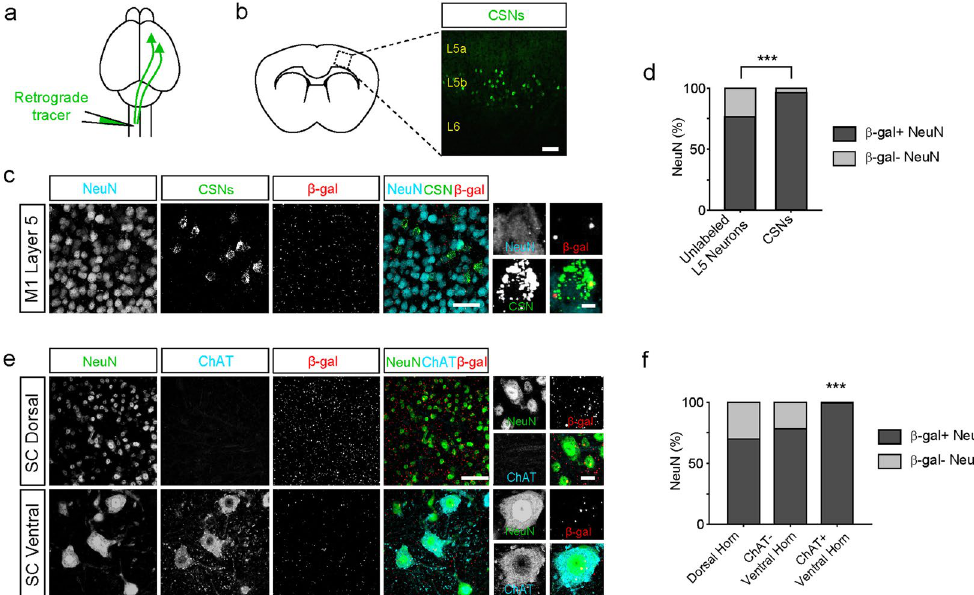
Figure 3. C9orf72 promoter activity is enriched in corticospinal and spinal motor neurons. ( a ) Schematic of the experimental design. Green fluorescent retrograde tracers were injected into the contralateral cervical spinal cord to retrogradely label corticospinal neurons in C9orf72 LacZ/ + mice. ( b ) Retrogradely labelled corticospinal neurons are shown in layer 5 (L5) of primary motor cortex. Scale bar: 100 μ m. ( c ) Representative images of L5 of motor cortex showing NeuN-positive neurons (cyan), retrogradely labelled corticospinal neurons (green) and β -gal staining (red). High magnification images show β -gal puncta within a corticospinal neuron ( rightmost panels ). Scale bars: 50 μ m and 5 μ m. ( d ) The percentage of unlabeled NeuN-positive neurons and of corticospinal neurons (CSNs) containing β -gal puncta in L5 of motor cortex (Unlabeled NeuN-positive neurons: 1357 of 1771 cells, 76.6%; CSNs: 132 of 137 cells, 96.4%; n = 5 mice for each group, p < 0.0001, Chi- Square test). Unlabeled NeuN-positive neurons and retrogradely labelled corticospinal neurons were analyzed from the same images. ( e ) Representative images of the dorsal ( top ) and ventral horn ( bottom ) of the spinal cord immunostained for NeuN (green), Choline acetyltransferase (ChAT; cyan), and β -gal (red). High magnification images show β -gal puncta within NeuN-positive neurons in the dorsal horn ( top right) and a ChAT-positive neuron in the ventral horn ( bottom right ). Scale bars: 50 μ m and 10 μ m. ( f ) The percentage of ChAT-negative and ChAT-positive neurons containing β -gal puncta in the dorsal and ventral horn of spinal cord (dorsal neurons: 734 of 1050 cells, 69.9%; ventral ChAT-negative neurons: 61 of 78 cells, 78.2%; ventral ChAT-positive neurons: 113 of 114 cells, 99.1%; n = 5 mice for each group; p < 0.0001, Chi-Square